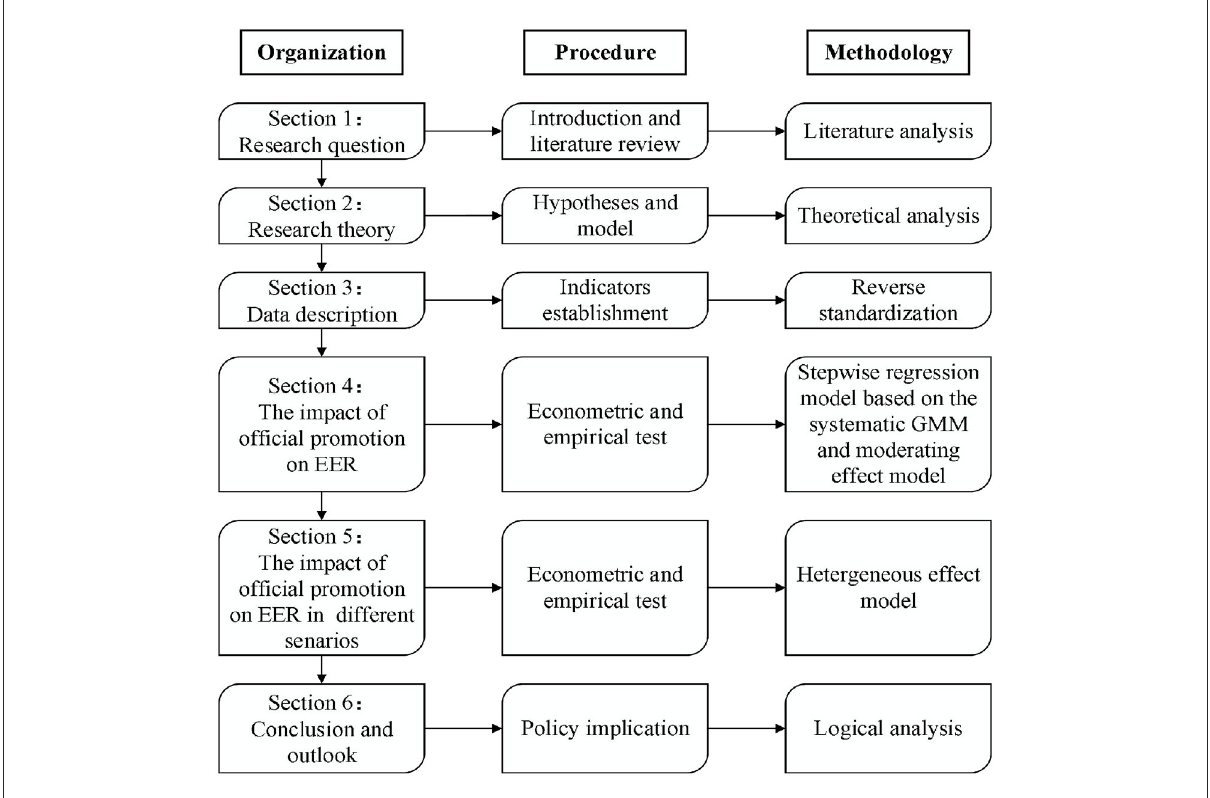
FIGURE1 The logical framework of this